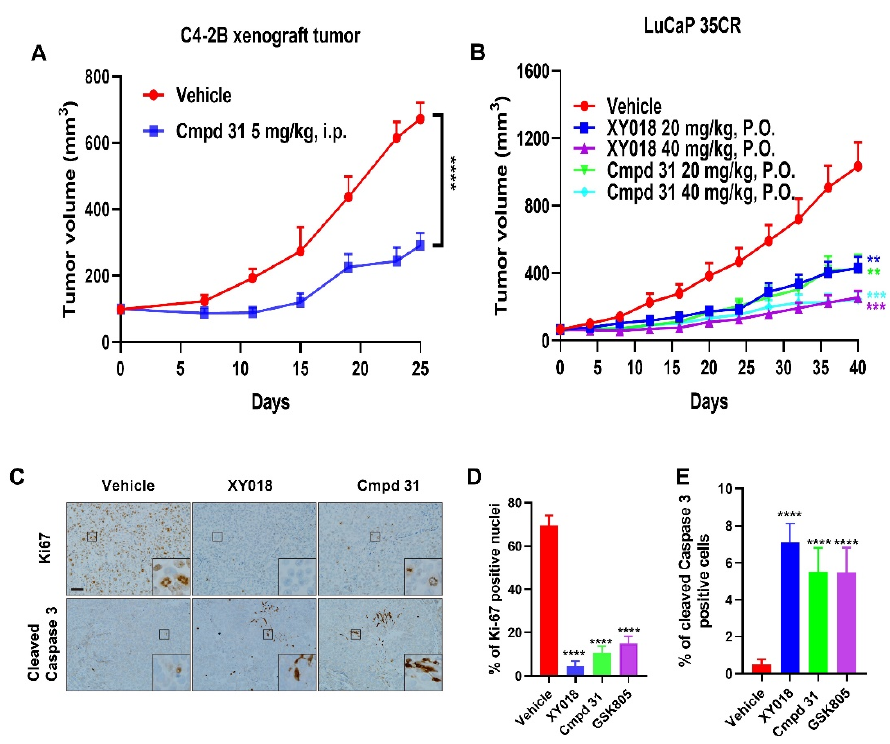
Figure 2. Orally administered ROR γ antagonists exhibit strong anti-tumor activities. ( A ) C4 − 2B cells were subcutaneously xenografted on the flanks of NOD − SCID mice. When tumors reached 100 mm 3 , mice were divided into two groups ( n = 8 tumors per group) and treated with vehicle or 5 mg/kg cmpd 31 (i.p.) five times per week for 25 days. Tumor volumes were monitored. ( B ) Mice with LuCaP-35CR PDX tumors were treated orally with ROR γ antagonists Cmpd 31 and XY018 (20 mg/kg or 40 mg/kg) or vehicle ( n = 8 tumors per group), five times per week. Tumor volumes were monitored. ( C ) Representative images from Ki − 67 and cleaved − Caspase − 3 immunohistochemistry of tumors from mice treated with 40 mg/kg of Cmpd 31, XY018, or vehicle. Scale bar: 50 μ m. ( D – E ) Quantitative analysis of anti-Ki-67 positive nuclei or anti-cleaved caspase 3 stained cells